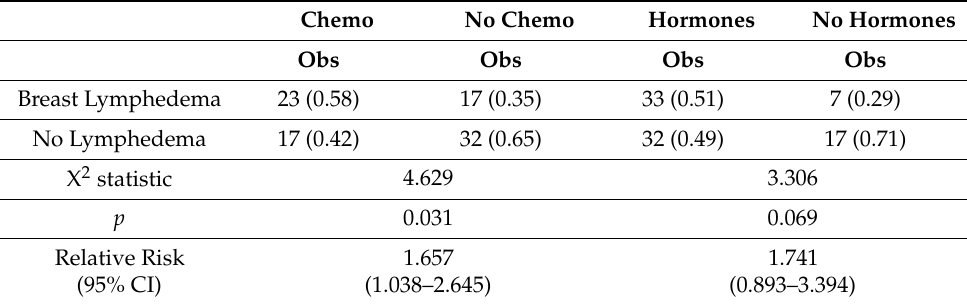
Table 3. Chi-squared test comparing receipt of chemotherapy and hormone